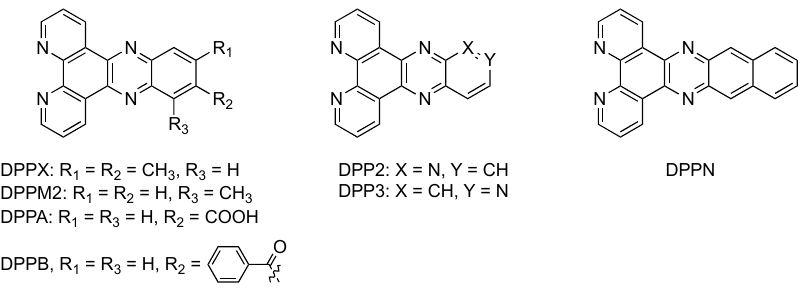
Figure 8. The seven DPPZ derivatives reported by Barton [11].